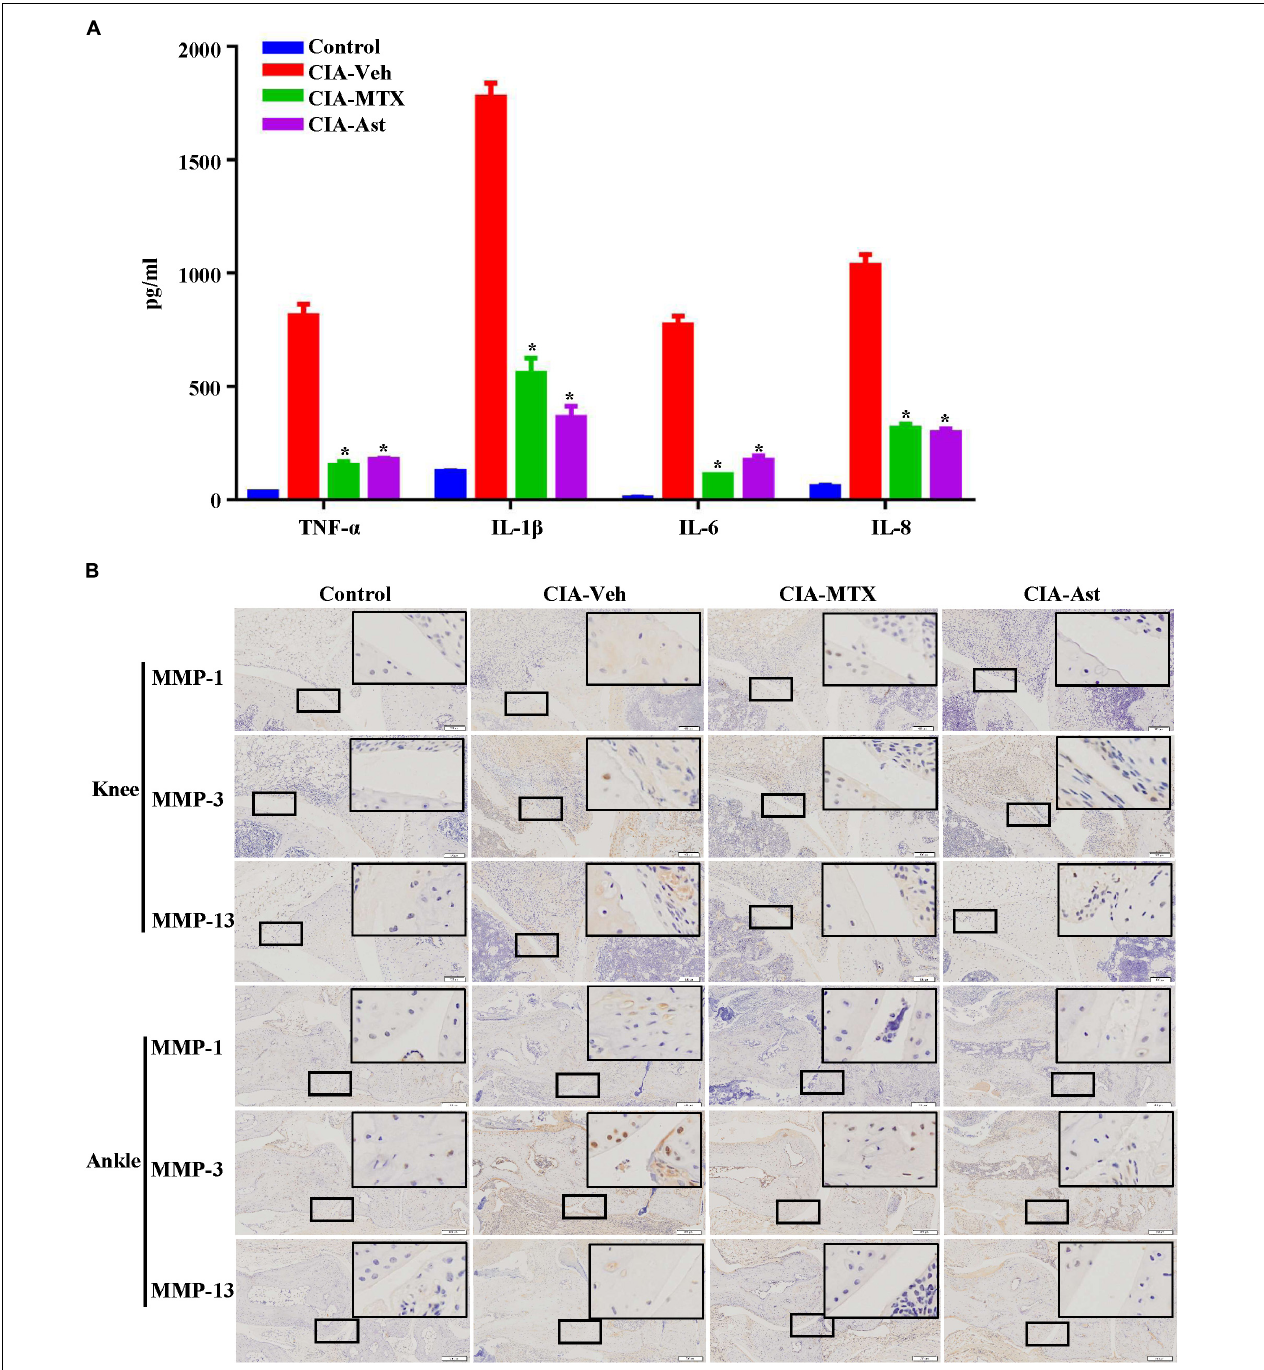
FIGURE 4 | Astragalin reduced the production of pro-inflammatory cytokines and the expression of MMPs in inflamed joints of CIA mice. The serum level of TNF- α , IL-1 β , IL-6, and IL-8 were determined using the ELISA assay (A) . Expression of MMP-1, MMP-3 (100 × ) and MMP-13 at the sites of cartilages and synovial tissues in the knee joints and the ankle joints (B) were measured by immune-histological staining. Representative images are shown from three independent experiments. Data are shown as mean ± SEM of ten mice per group, ∗ p < 0.05, ∗∗ p < 0.01 versus CIA-Veh group.